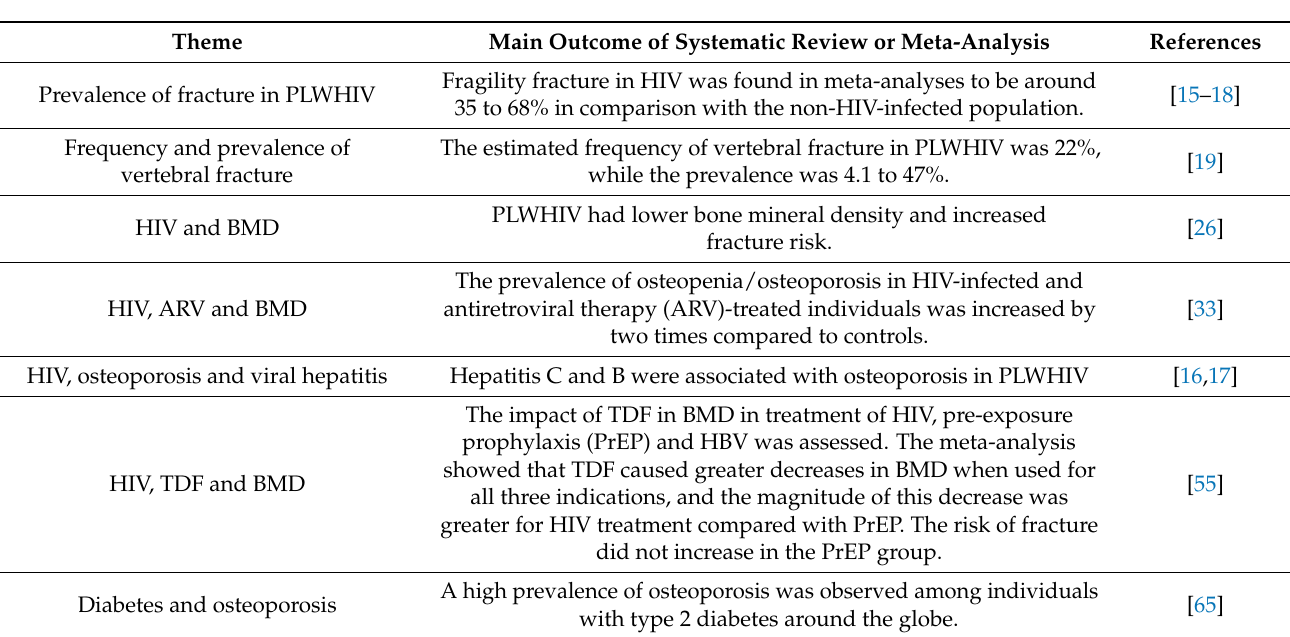
Figure 3. Diagram showing the proposed steps for the management of osteoporosis in acute and chronic HIV. Table 1. Summary of all the systematic reviews and meta-analyses included in this review. This will allow the readers to have detailed summary of updates in the field of HIV. TDF (tenofovir disoproxil fumarate); BMD (bone mineral